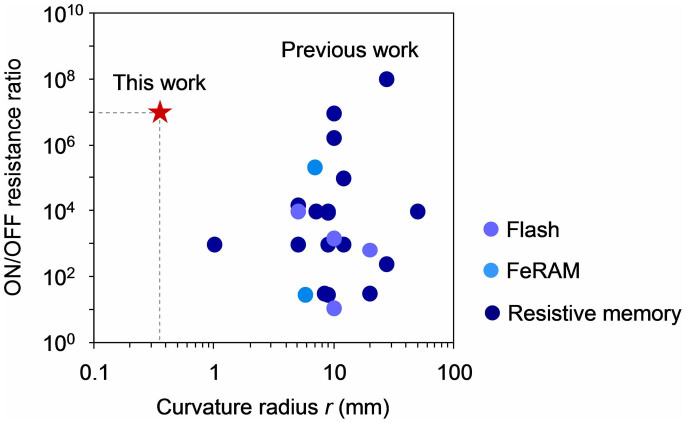
Flexible properties on nonvolatile memory devices as functions of ON/OFF resistance ratio and curvature radius.Several types of flexible nonvolatile memories including flexible flash memory13141516, flexible FeRAM1819 and flexible resistive memory20212223242526272829303132333435363738 are shown.